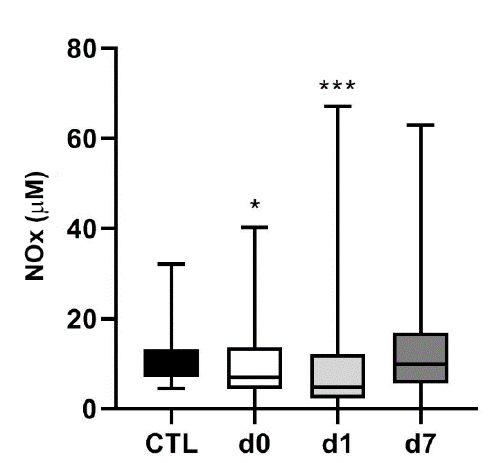
Figure 4. Circulating NOx levels in hemorrhagic stroke patients. NOx levels were measured in the same healthy volunteers (CTL) and hemorrhagic stroke patients as in Figure 1. In patients, blood samples were taken on admission (d0), 24 h later (d1), and at hospital discharge (d7). Box plots represent the interquartile range with the median as a horizontal line. Whiskers encompass the maximum and minimum values of the population. *: p < 0.05; ***: p < 0.001 vs. CTL.